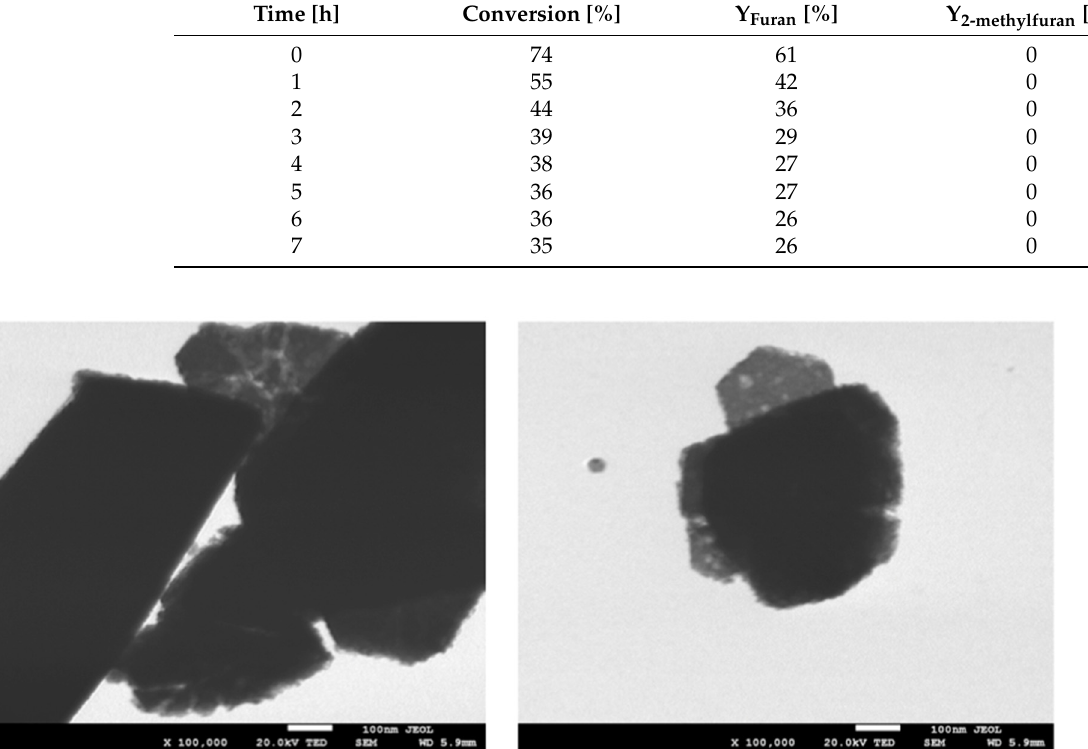
Figure A5. TEM images of the H-Z sample.